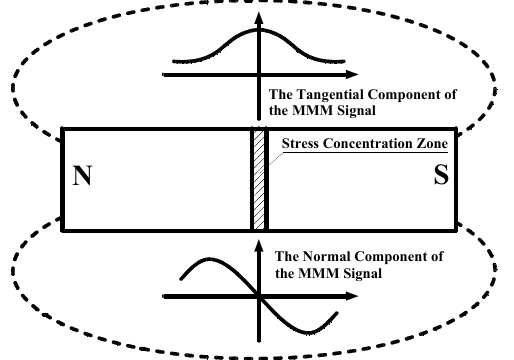
Figure 1. Schematic diagram of the commonly used criteria for stress concentration by the metal magnetic memory (MMM) method.